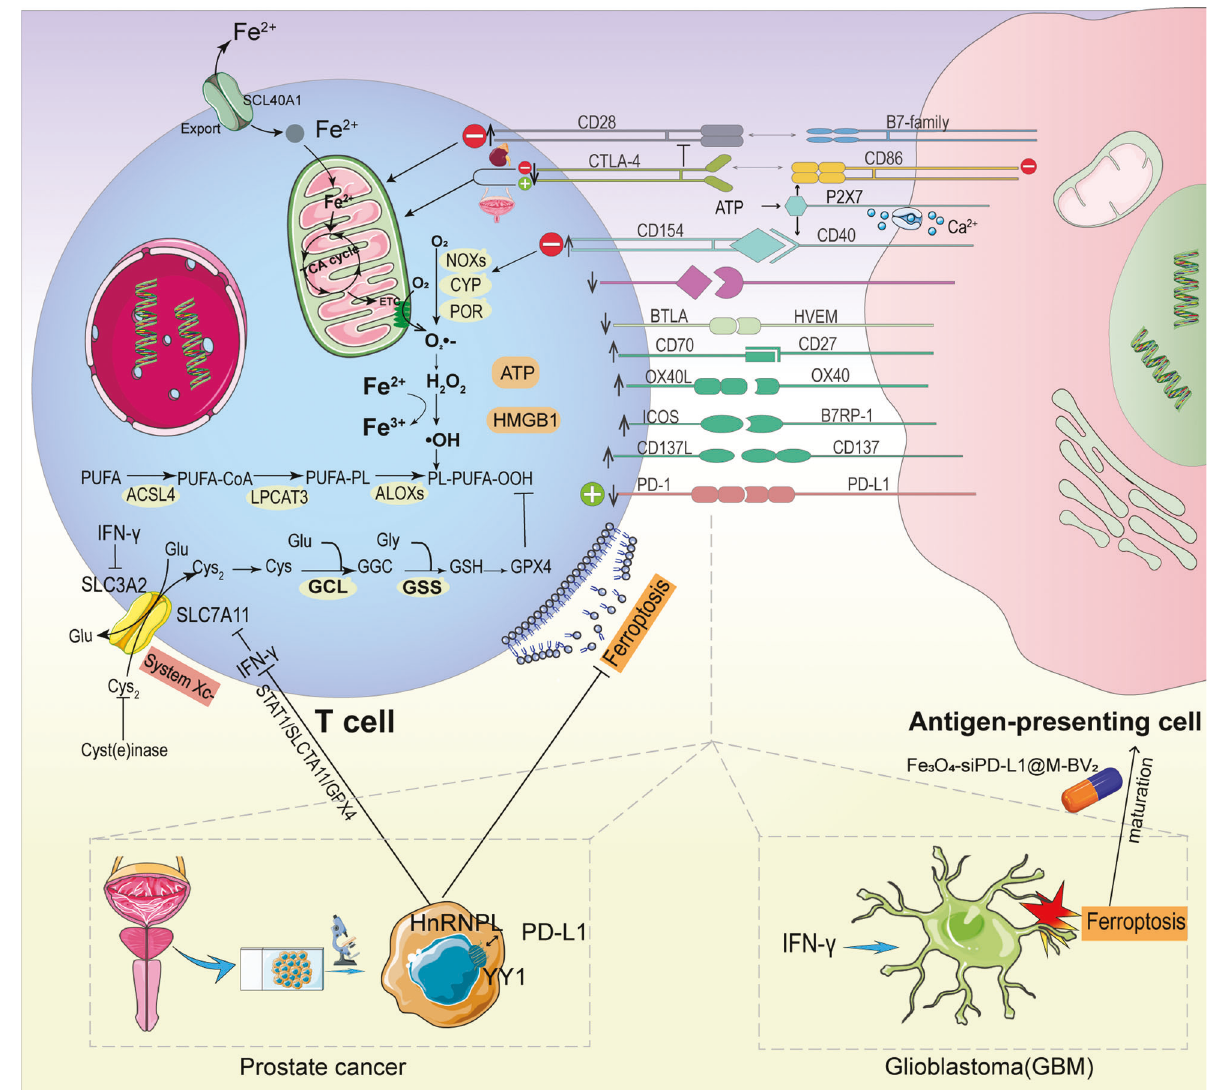
Fig. 2 Co-stimulatory, co-inhibitory and checkpoint pathways. In addition to the co-stimulatory, co-inhibitory and checkpoint pathways, there are other stimulatory and inhibitory pathways (respectively indicated by upward and downward arrows,) that impact the immune response, including tumor necrosis factor (TNF)-related molecules, other members of the CD28 family, adhesion molecules, and T-cell immunoglobulin and Mucin (TIM) molecules. Various stimulatory and inhibitory pathways can affect the onset of ferroptosis in immune cells and tumor cells via a wide range of mechanisms, ultimately facilitating (green plus) or inhibit (red minus) immune tolerance. Moreover, prostate cancer cells could upregulate PD-L1 through HnRNPL over-expression, which in turn inhibits IFN- γ released by CD8 + T cells via the STAT1/SLC7A11/GPX4 signaling axis. Subsequently, the expression of SLC3A2 and SLC7A11 (two subunits of system Xc-) increases, suppressing lipid peroxidation by facilitating cystine uptake, which ultimately contributes to ferroptosis evasion and dampens tumor immunity. Likewise in GBM, activated CD8 + T cells could release IFN- γ , inducing ferroptosis in cancer cells. Fe3O4-siPD-L1@M-BV2, a novel GBM-targeted pharmaceutical delivery system, could stimulate ferroptosis for immunotherapy of drug-resistant GBM and establish a cascade of ampli fi cation between ferroptosis and immune CTLA-4 . CTLA-4 blockade contributed to the CD28-mediated proliferation of tumor-associated Tregs, inducing tumor immune tolerance ultimately. This procedure allows polyclonal Treg repertoire to be pre-enriched for recognizing antigens submitted by tumor-associated conventional dendritic cells (CDCs). Unsteady CDC contacts ensured Treg capability, while CTLA-4-mediated downregulation of CDC co-stimulatory B7 proteins, via Tregs, resulted in contact instability. CTLA-4-blockade sparked CD28- dependent Tregs hyper-proliferation in the TME. Therefore, the blockade of CTLA-4 may lessen therapeutic bene fi ts in cancer patients [116].